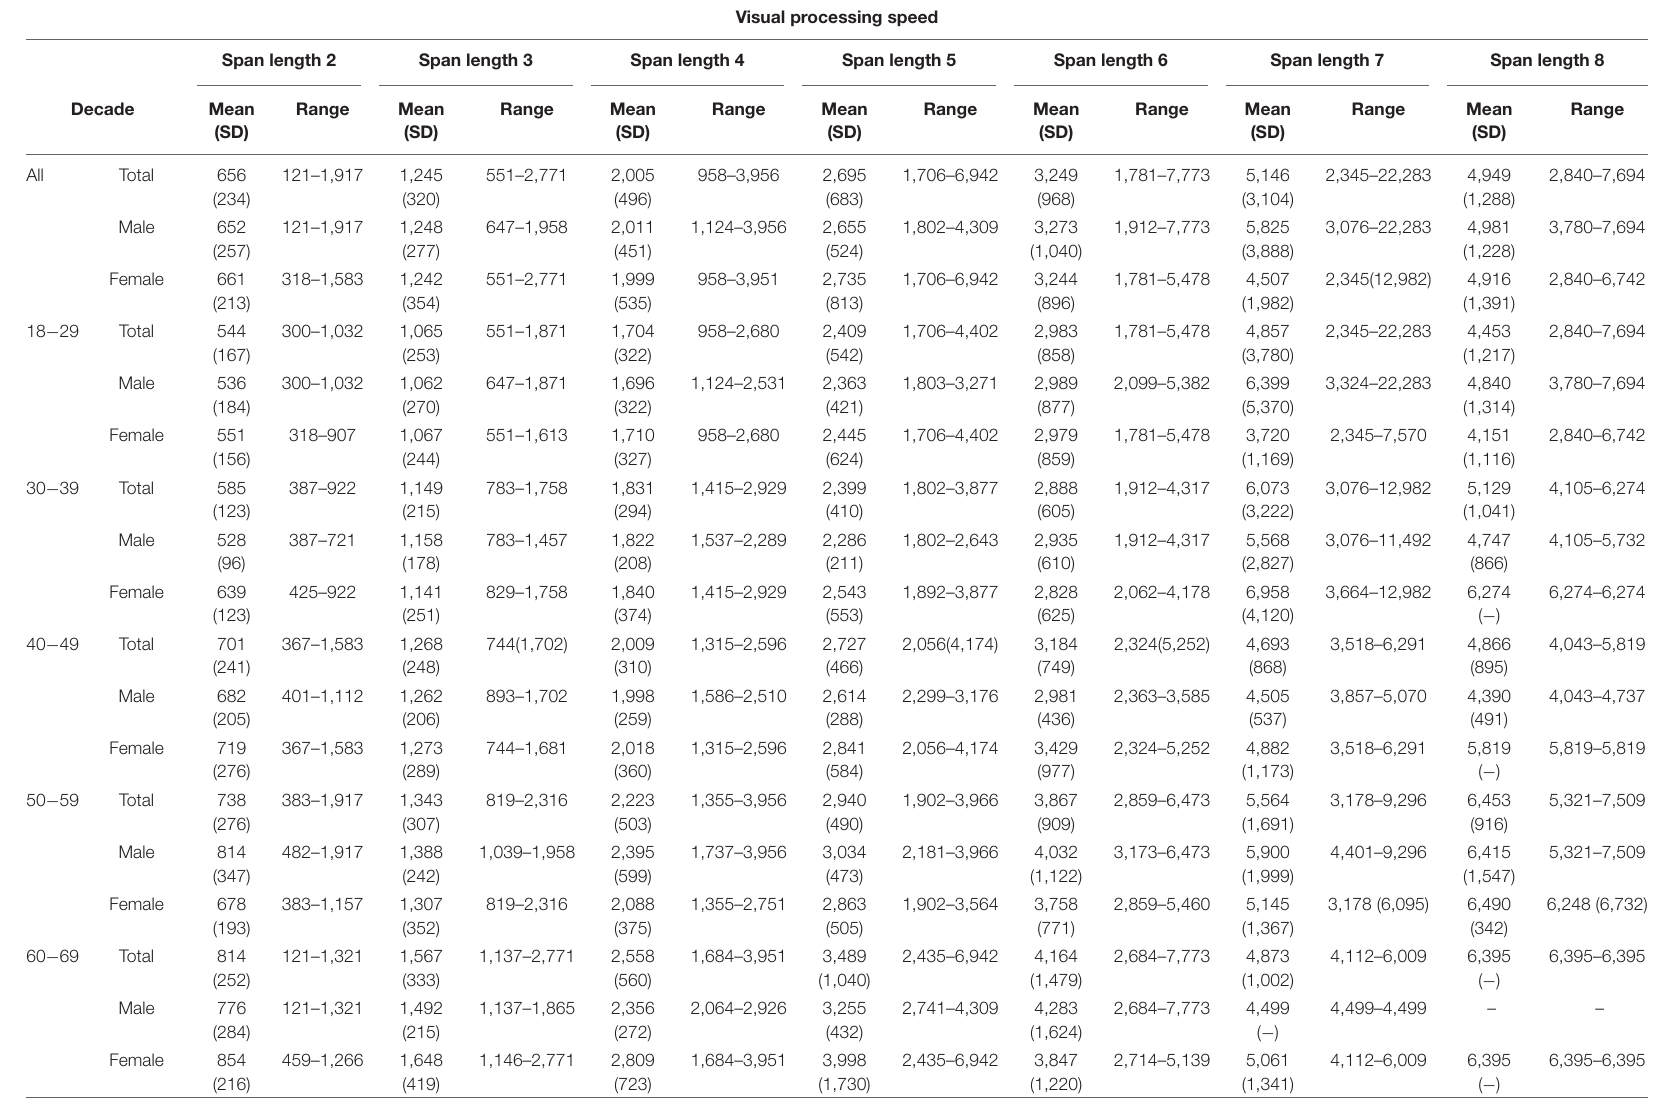
TABLE 6 | Descriptive data for visual processing speed (ms) of the backward corsi tapping